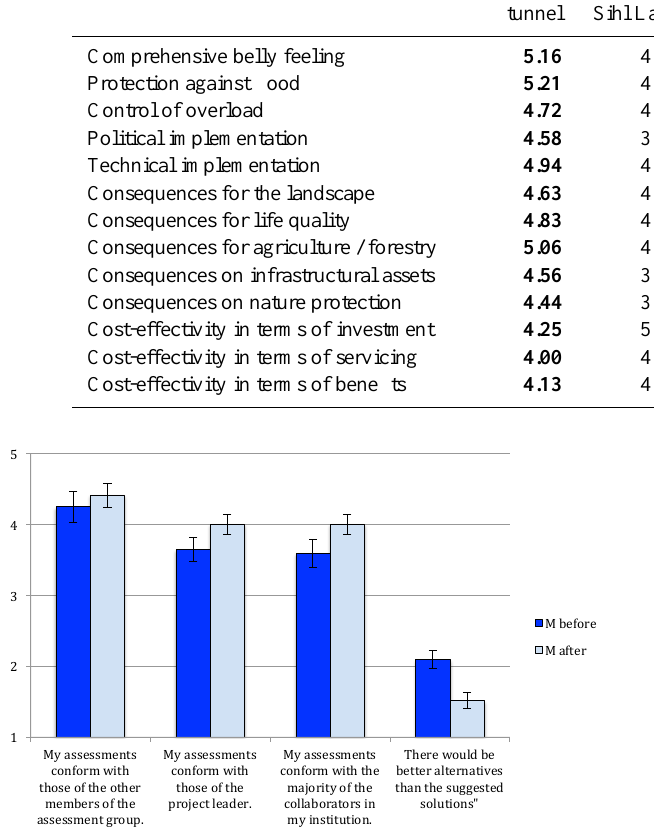
1 Figure 5: The participants’ perceived consensus before (T1) and after (T2) the assessment 2 process.